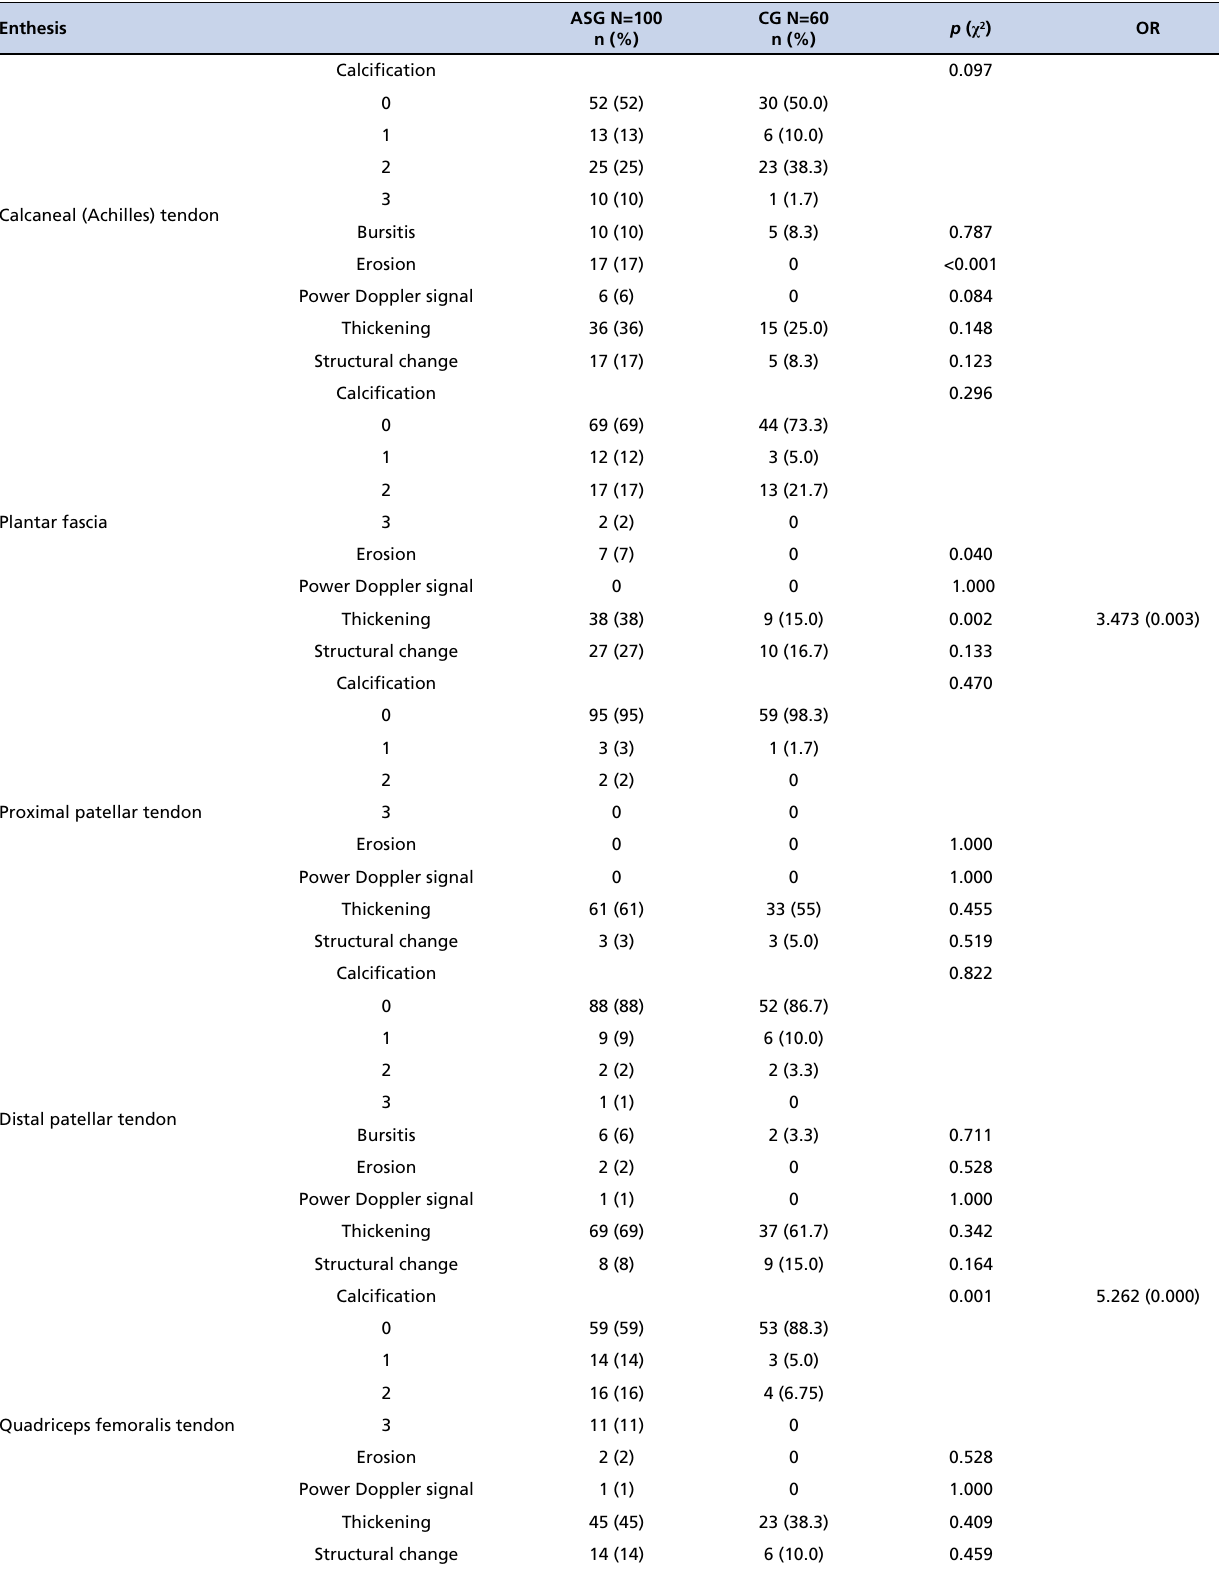
Table 3 - Comparison of ultrasonographic findings of the entheses between groups.